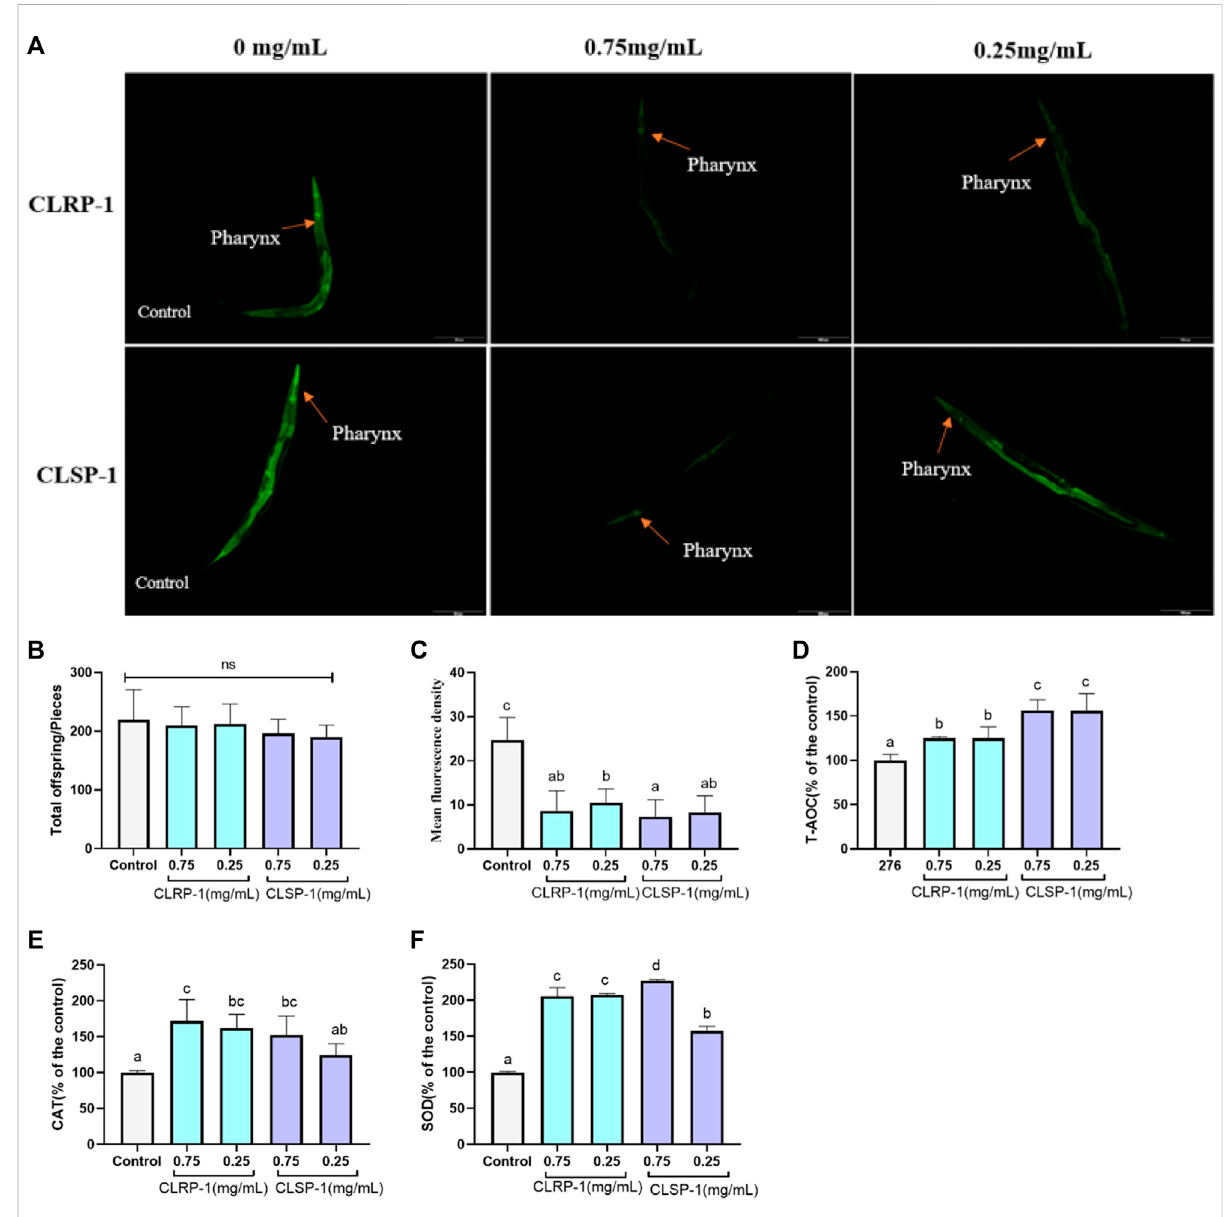
FIGURE 5 EffectofCLRP-1andCLSP-1onROSlevelandantioxidantenzymesactivitiesunderthermalstress. (A) FluorescenceintensityofROS. (B) CLRP- 1 and CLSP-1 have no reproductive toxicity to normal C. elegans. (C) CLRP-1 and CLSP-1 could reduce ROS levels. (D) CLRP-1 and CLSP-1 could enhance T-AOC. (E) CLRP-1 and CLSP-1 could enhance CAT activities. (F) CLRP-1 and CLSP-1 could enhance SOD activities. ns indicates a statistically difference with p > 0.05. Bars with different lowercase letters (a – d) are signi fi cantly different ( p <